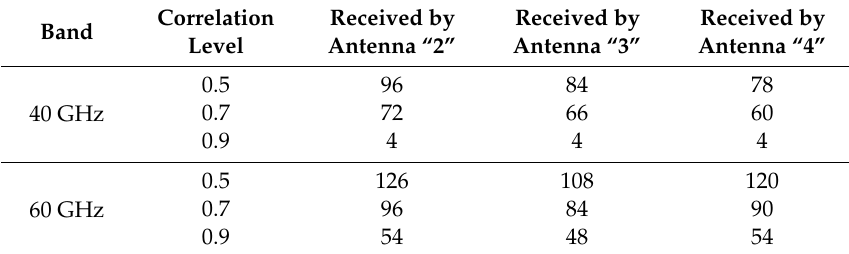
Table 6. The 99th percentile of coherence bandwidth (MHz), in the corridor, OLOS.